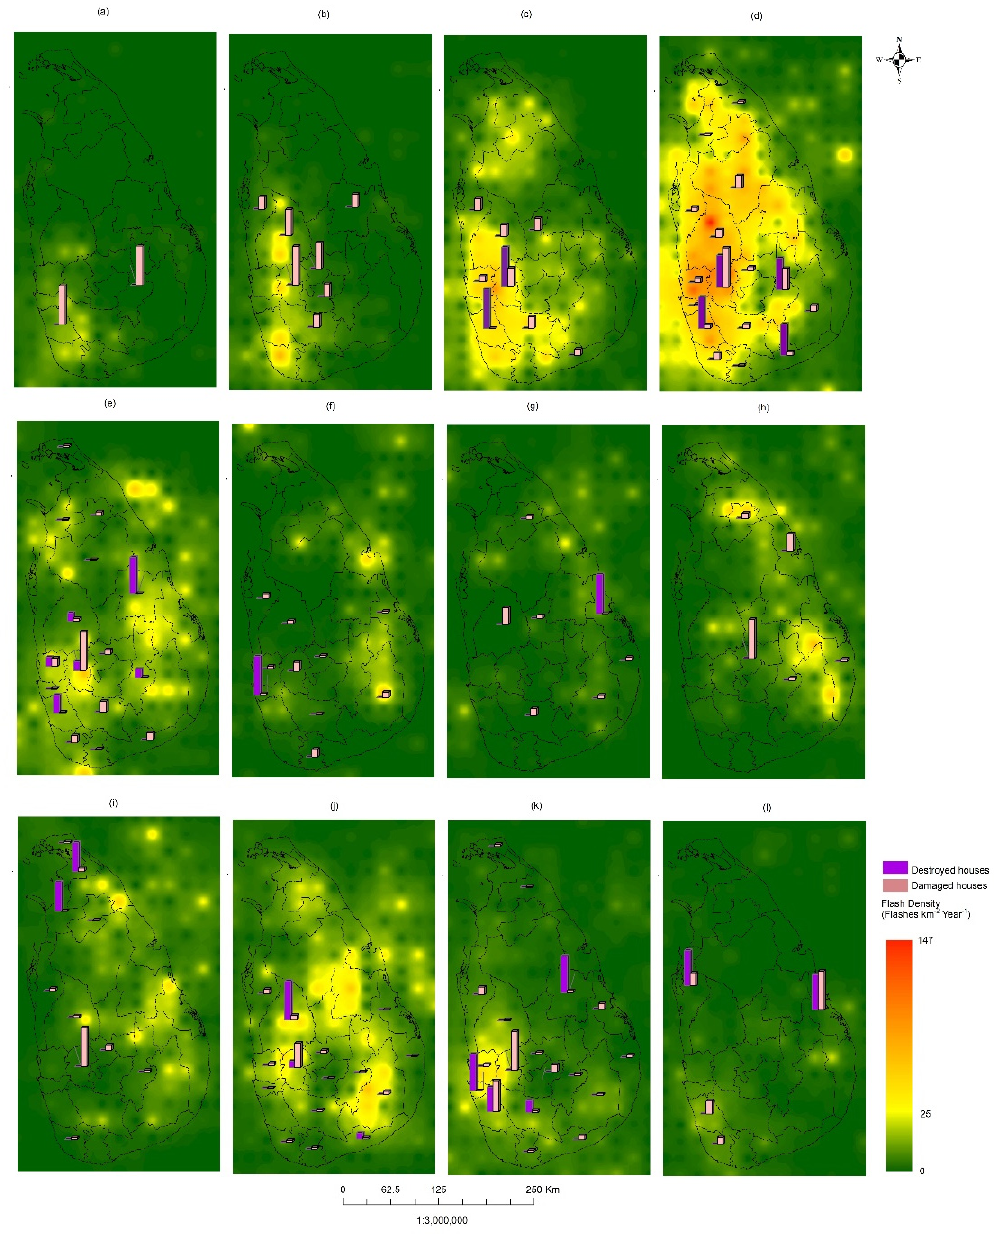
Figure 13. Variation of the lightning flash density with the recorded property damage (in %) in Sri Lanka, from 1974 to 2019, for all 12 months, presented district-wise: ( a ) January, ( b ) February, ( c ) March, ( d ) April, ( e ) May, ( f ) June, ( g ) July, ( h ) August, ( i ) September, ( j ) October, ( k ) November, and ( l ) December.